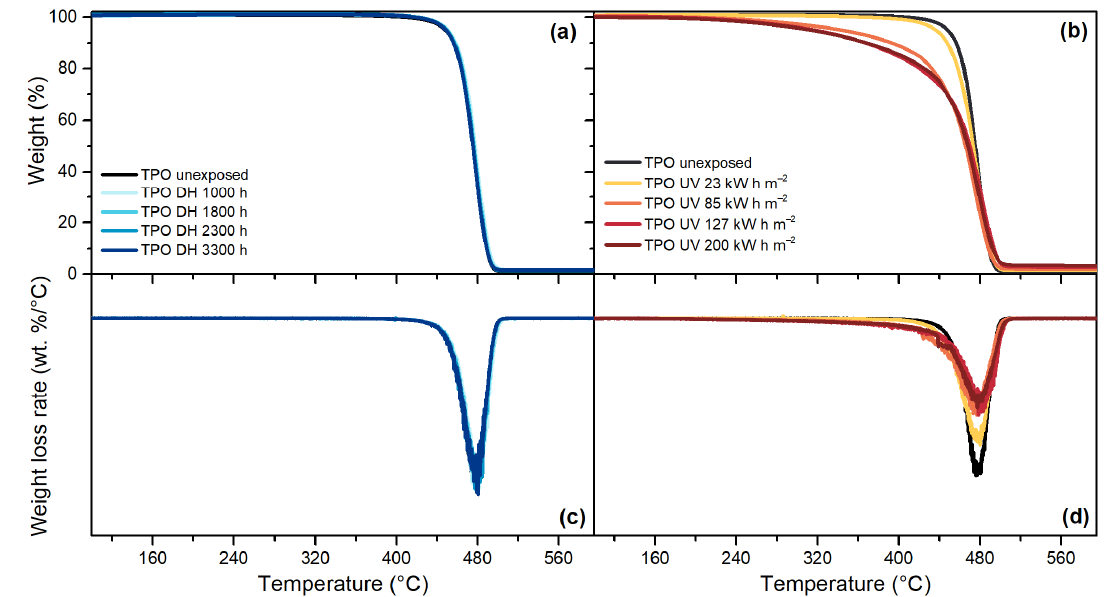
Figure 13. Residual weight over temperature during TGA measurements of TPO after the exposure to DH test ( a ). Residual weight over temperature during TGA measurements of TPO after the exposure to UV test ( b ). Weight loss rate over temperature of TPO samples exposed to DH test ( c ). Weight loss rate over temperature of TPO samples exposed to DH test ( d ).